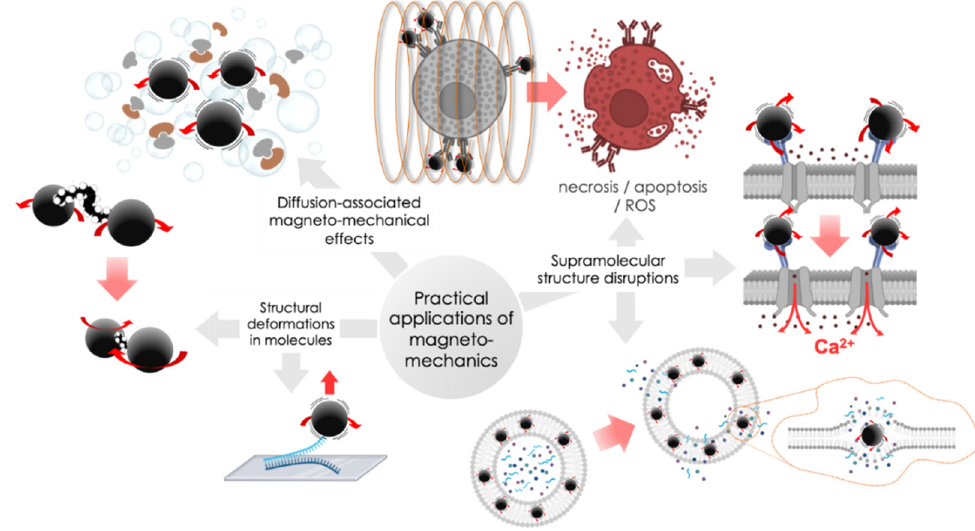
Figure 6. Schematical representation of magneto-mechanical actuations realized in practice.